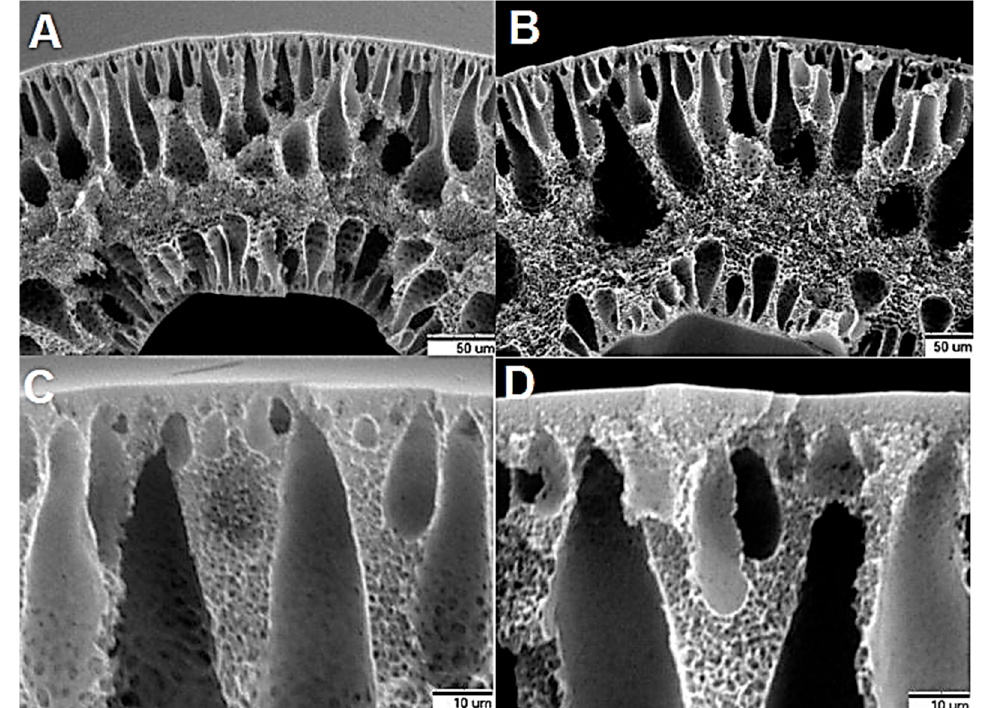
Figure 6. Scanning electron microscopy cross section images of ( A ) pristine polysulfone; ( B ) polysulfone/graphene oxide mixed matrix membrane (magnification ×1.5 k); ( C ) pristine polysulfone; and ( D ) polysulfone/graphene oxide mixed matrix membrane (magnification ×10 k) [105]. Reproduced with permission from Creative Commons Attribution 3.0 license.